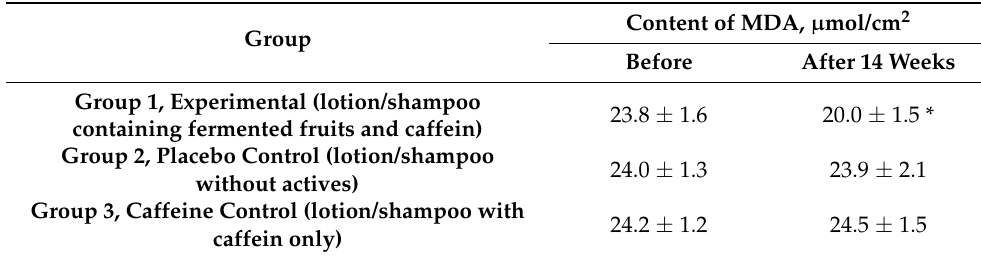
Content of MDA, µ mol/cm 2 Before After 14 Weeks 24.0 ± 1.3 24.2 ± 1.2 24.5 ± 1.5